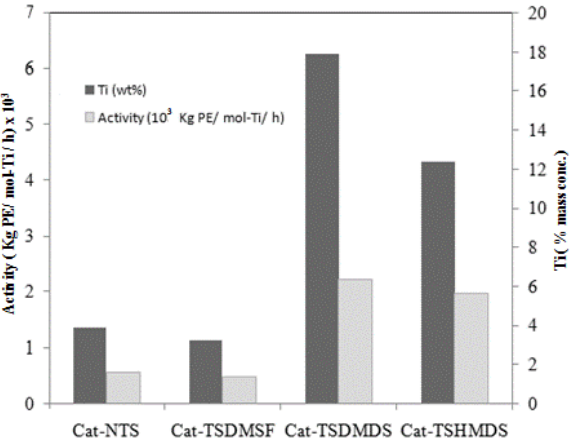
Figure 3. Relationship between the surface concentrations of Ti and the activities of catalysts.